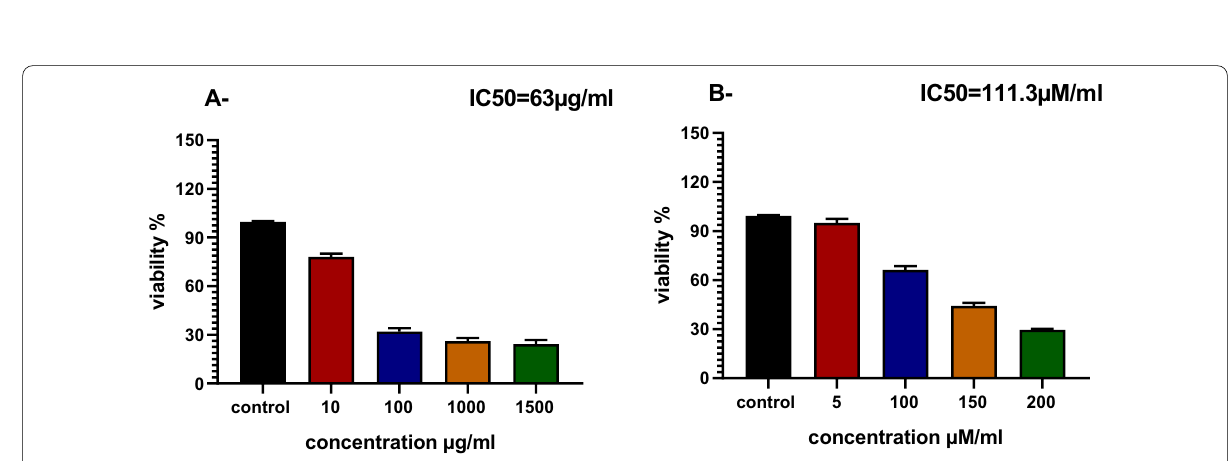
3) A treatment with eucalyptus =